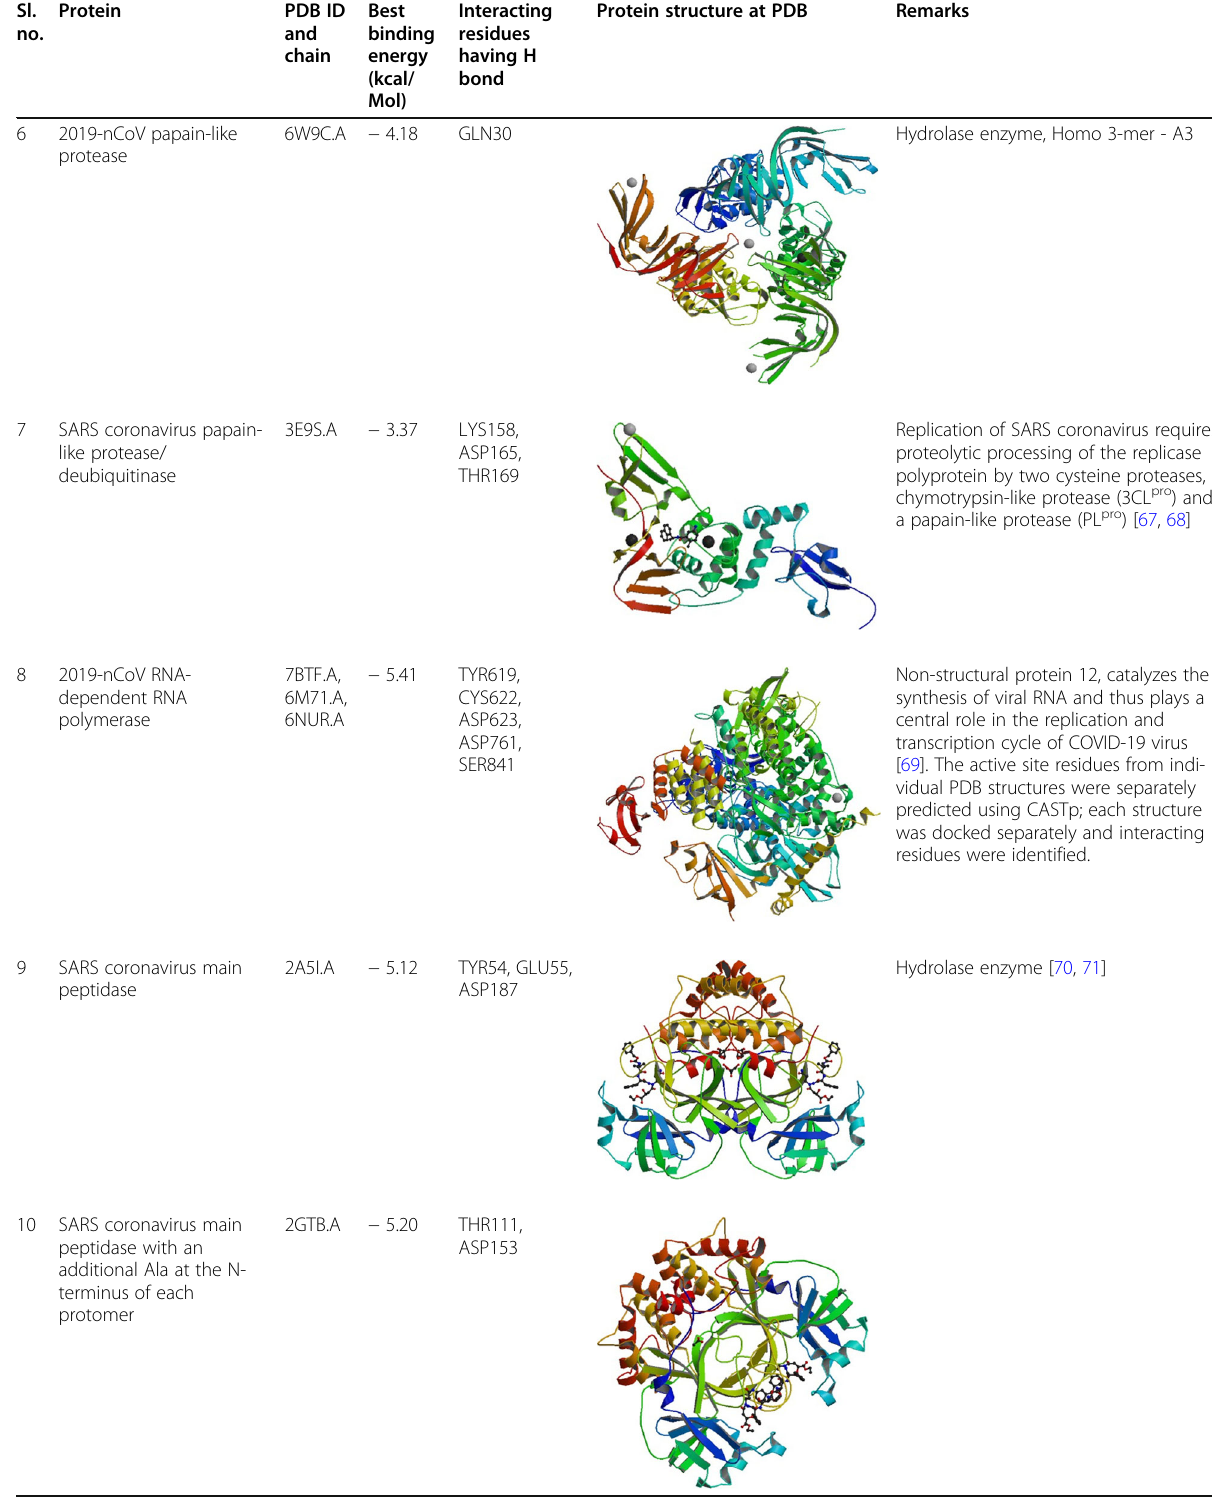
Table 2 Molecular docking of various proteins of coronavirus with quercetin ligand (Continued) Sl. no.